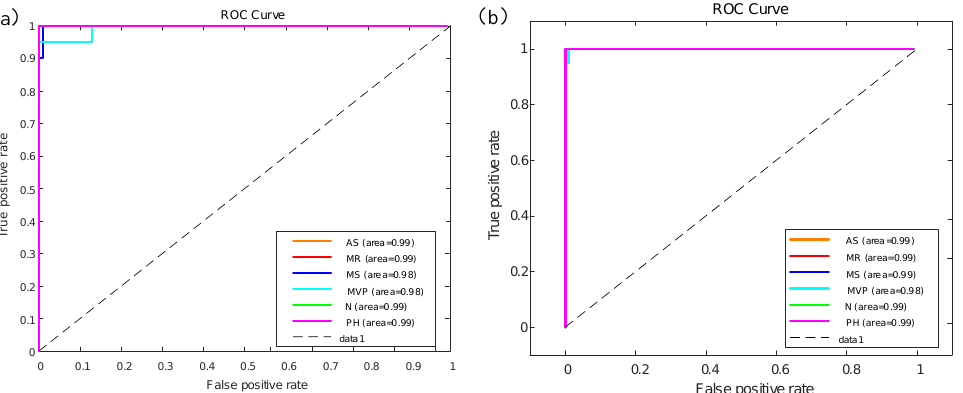
Figure 8. ROC curve for ( a ) the augmented heart sound classification based on GoogleNet; ( b ) the original heart sound classification based on GoogleNet.